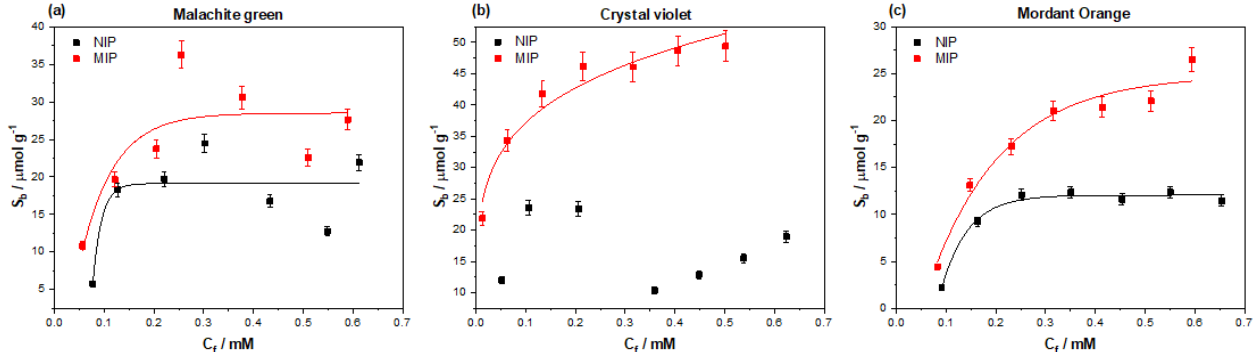
Figure 10. The binding isotherms outlining the interactions of ( a ) malachite green, ( b ) crystal violet, and ( c ) mordant orange with MIP/NIP 205. The plotted values for each of the binding isotherms were extrapolated from the absorbance peaks for each compound at their λ max values (616, 590, and 385 nm respectively), enabling C f values to be calculated and subsequently S b values.